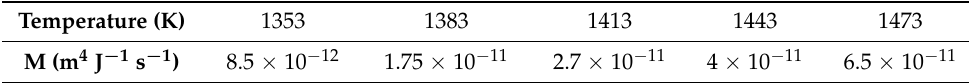
Table 4. Values of M for the studied superalloy.